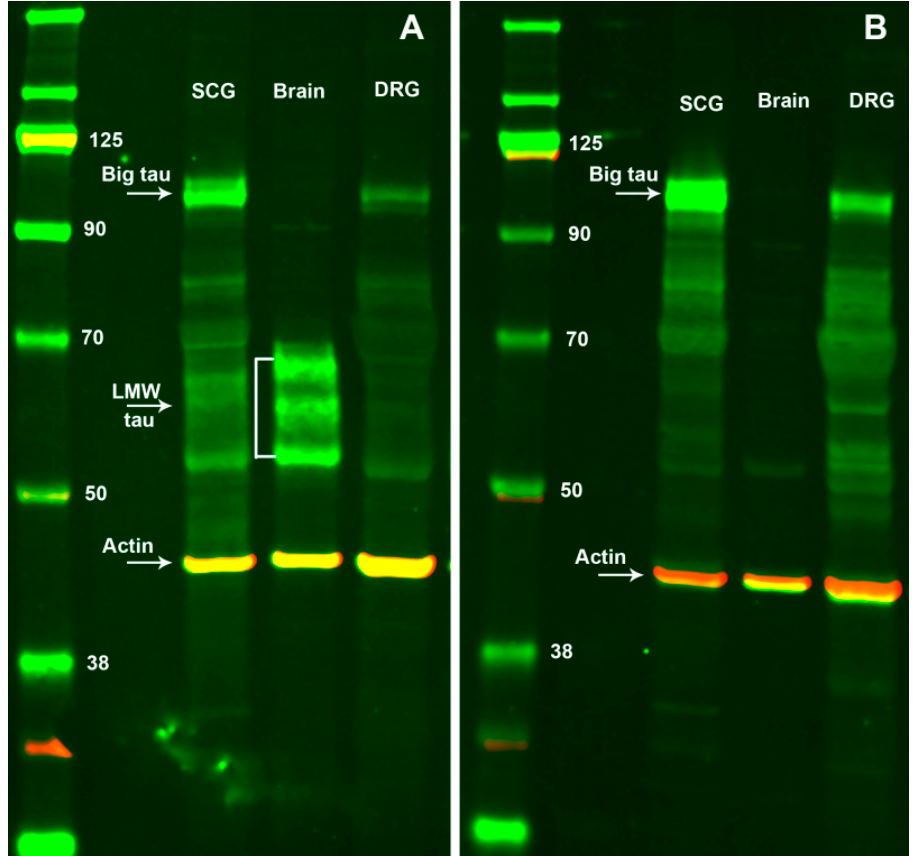
Figure 1. Expression of tau isoforms in SCG compared to brain and DRG tissues. Western blots stained with 3 ′ tau antibodies (recognize all tau isoforms) show in ( A ) the low molecular weight isoforms of tau (LMW, 45–60 kDa) in brain only, while Big tau (110 kDa) is detected in SCG and DRG but not in brain. Western blots stained with the Big tau specific antibody, shown in ( B ), verified Big tau expression in SCG and DRG and its absence in brain. The blots included a pre-stained protein ladder and were probed for expression of actin (42 kDa) as a marker for loading variations.